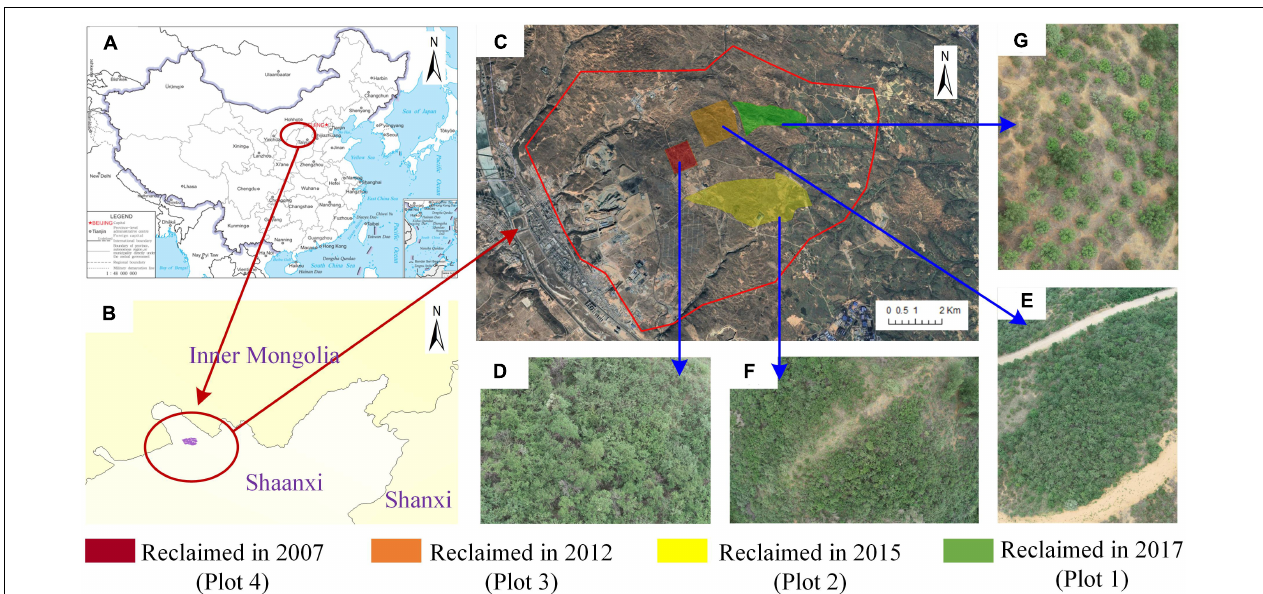
FIGURE 1 | (A,B) The geographic locations of the study area, (C) the area sampled, and (D–G) photographs of Hippophae rhamnoides that were reclaimed in 2007, 2012, 2015, and 2017,